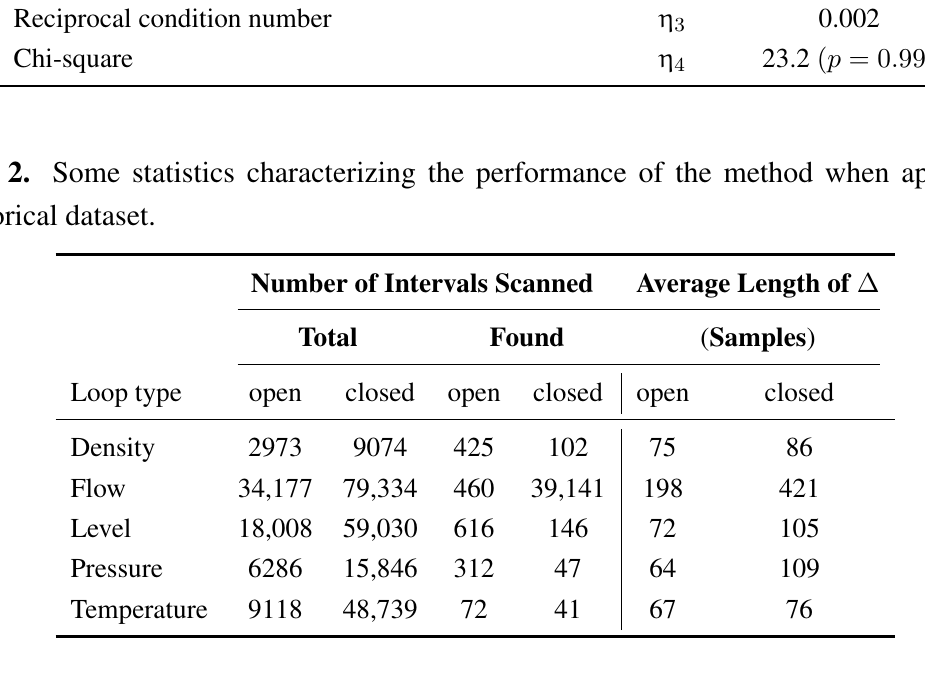
Table 3. Counts for the deepest test T the condition causing the algorithm to exit the scanning E